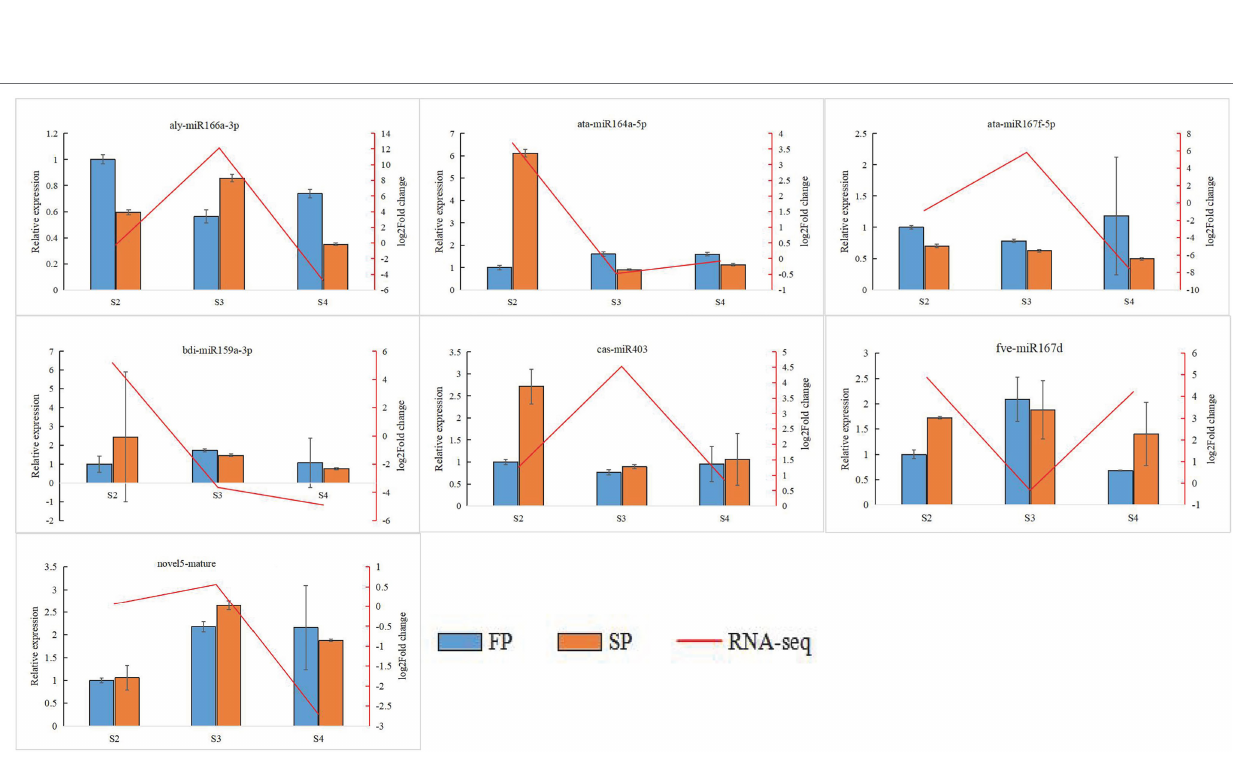
FIGURE 7 | Quantitative real-time PCR analysis of DEMIs. The error bar represents the error values of three biological